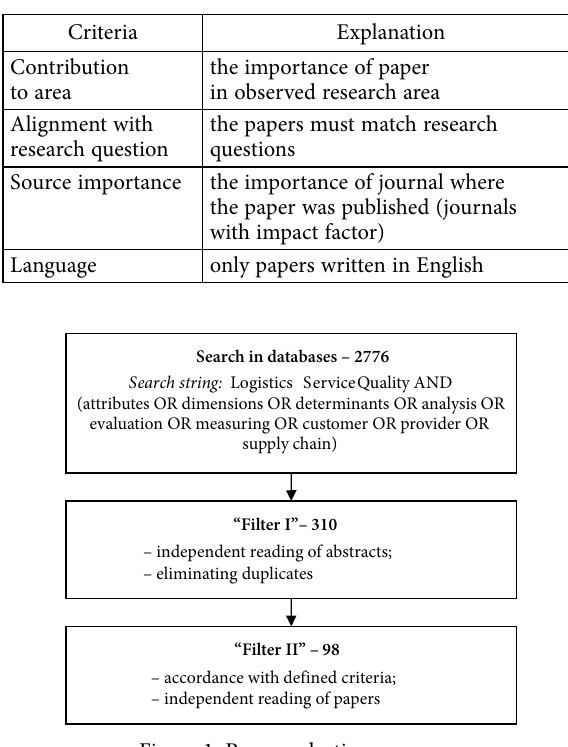
Figure 1. Papers selection process